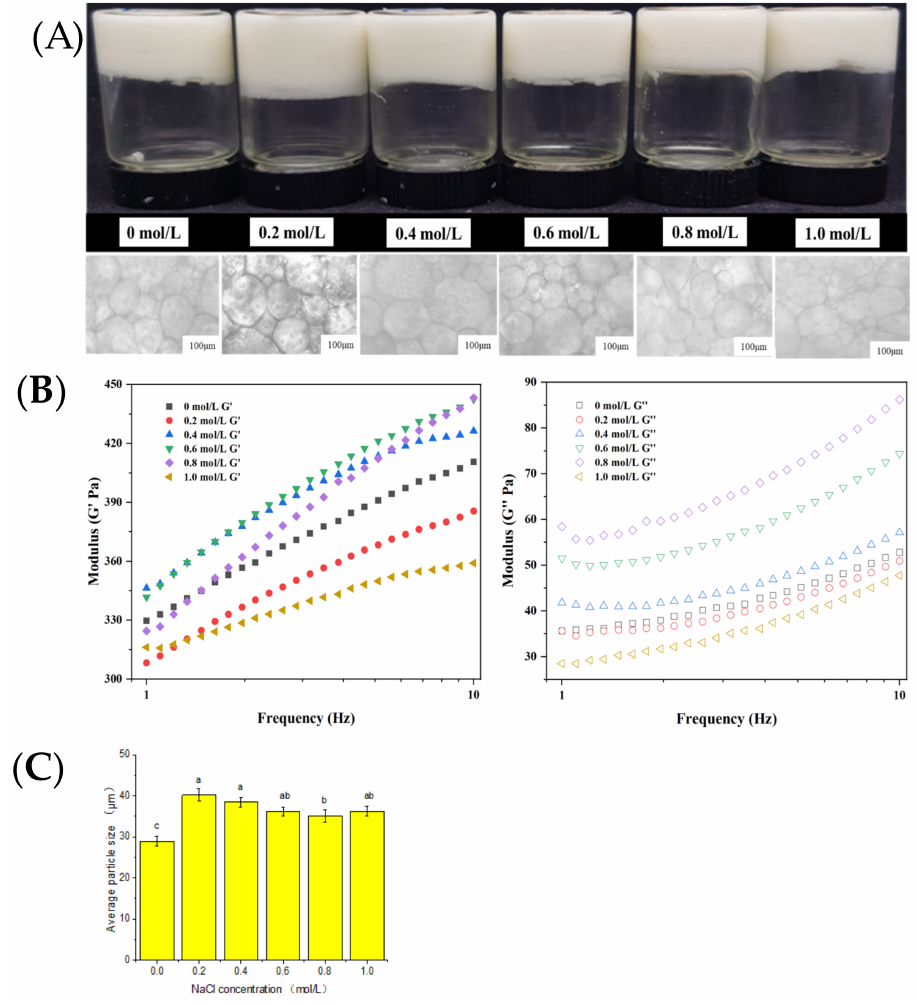
Figure 7. Characteristics of emulsion gel (protein concentration, c = 2.5 wt.%, and oil ratio ø = 0.68) under different NaCl concentrations. ( A ) Visual appearance (upper row) and optical microscope image (lower row) of emulsion gel under different NaCl concentrations (scale bar = 100 µ m). ( B ) The influence of shear frequency (frequency is 1 Hz, and strain is 0.5%) on the elastic modulus (G’, solid) and loss modulus (G”, hollow) of emulsion gel under different NaCl concentrations (0.2 mol/L, 0.4 mol/L, 0.6 mol/L, 0.8 mol/L, and 1.0 mol/L). ( C ) The average particle size of emulsion gel (d 3,2